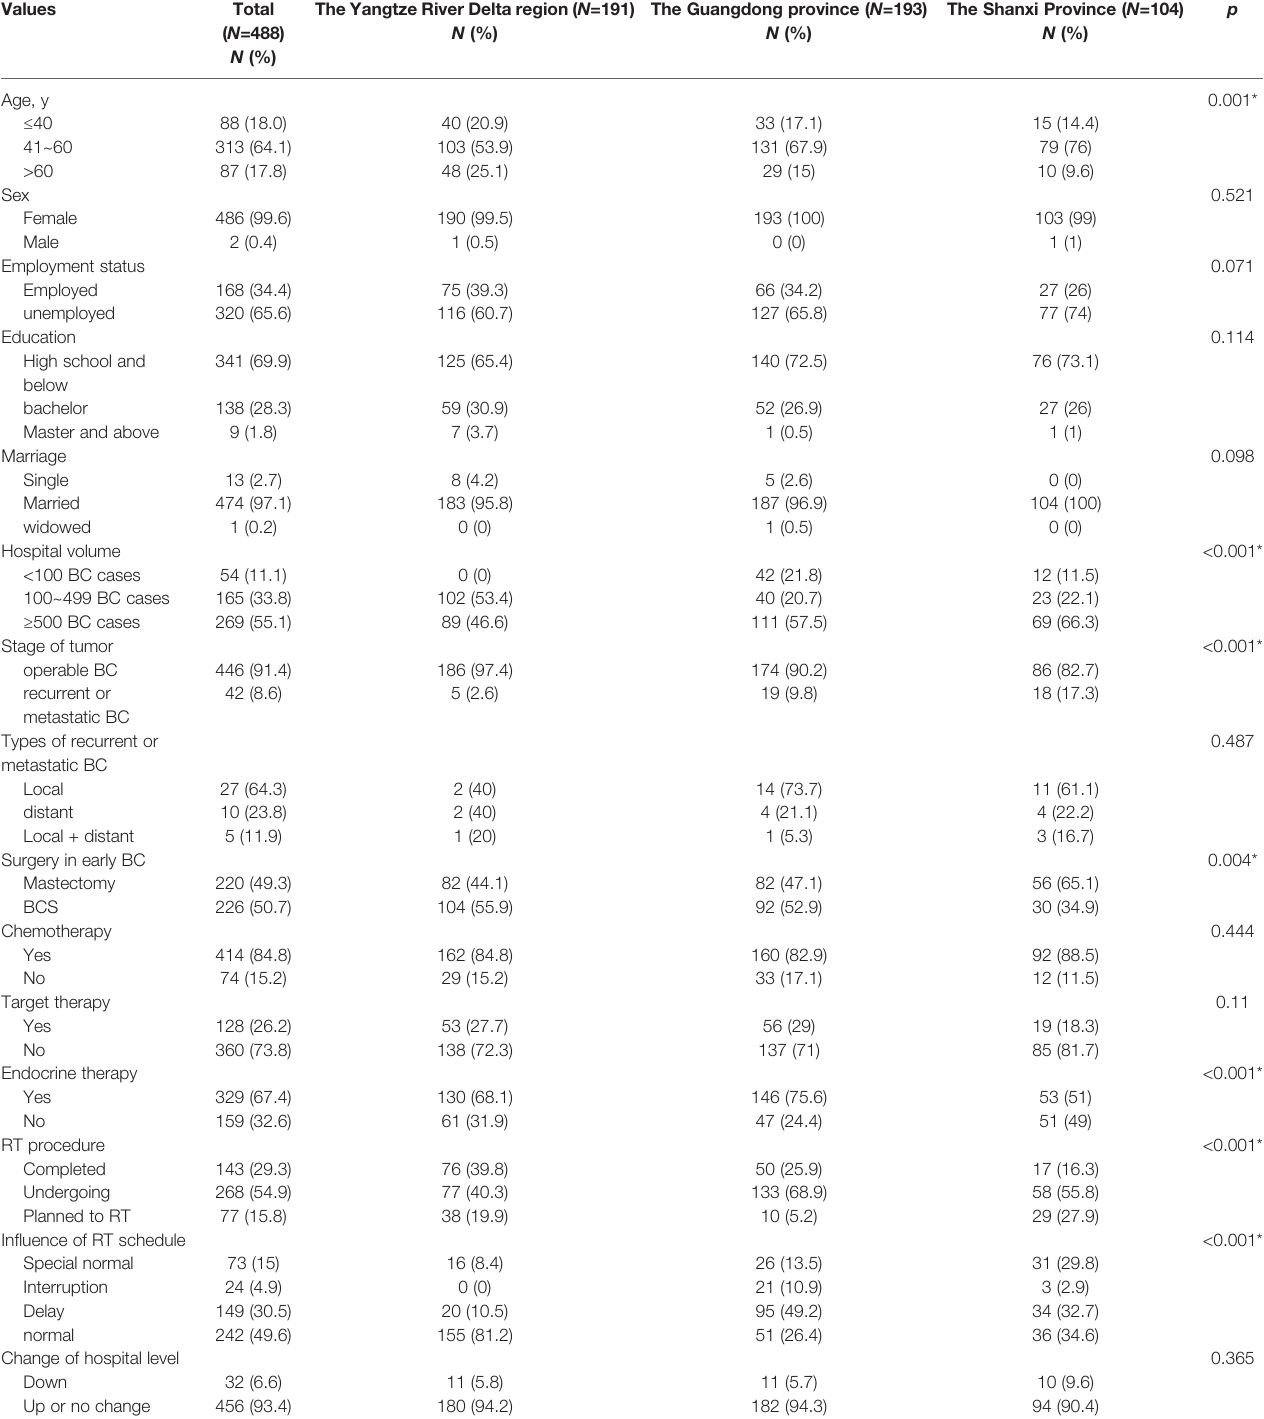
TABLE 1 | Characteristics of demographic, treatment and in fl uence of COVID-19(N=488). Values Total